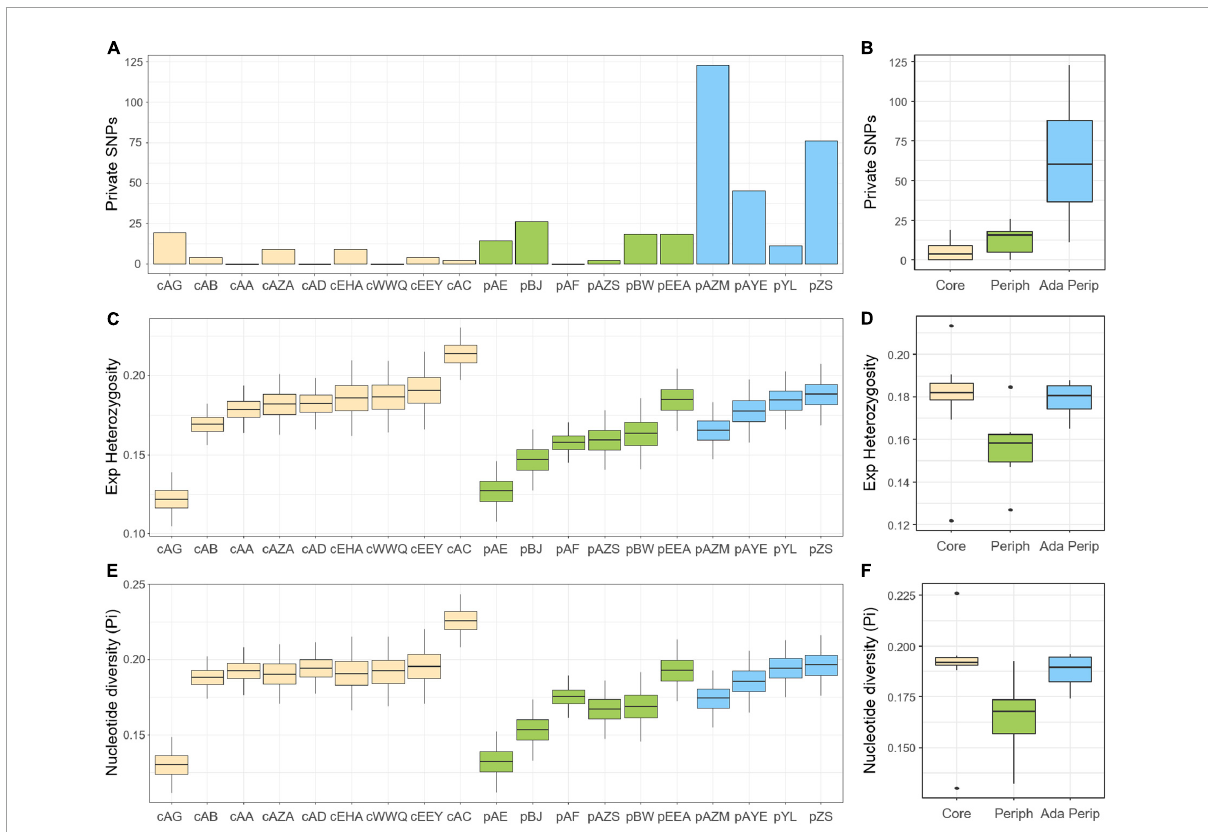
FIGURE3 Genetic diversity of Ammopiptanthus mongolicus populations shown as (A,B) numbers of private alleles, (C,D) expected heterozygosity, and (E,F) nucleotide diversity ( π ). (A,C,E) reveal the genetic diversity distribution of all samples in each population; (B,D,F) reveal the average genetic diversity distribution of populations in the core, non-adaptive peripheral, and adaptive peripheral groups, denoted by yellow, green, and blue,